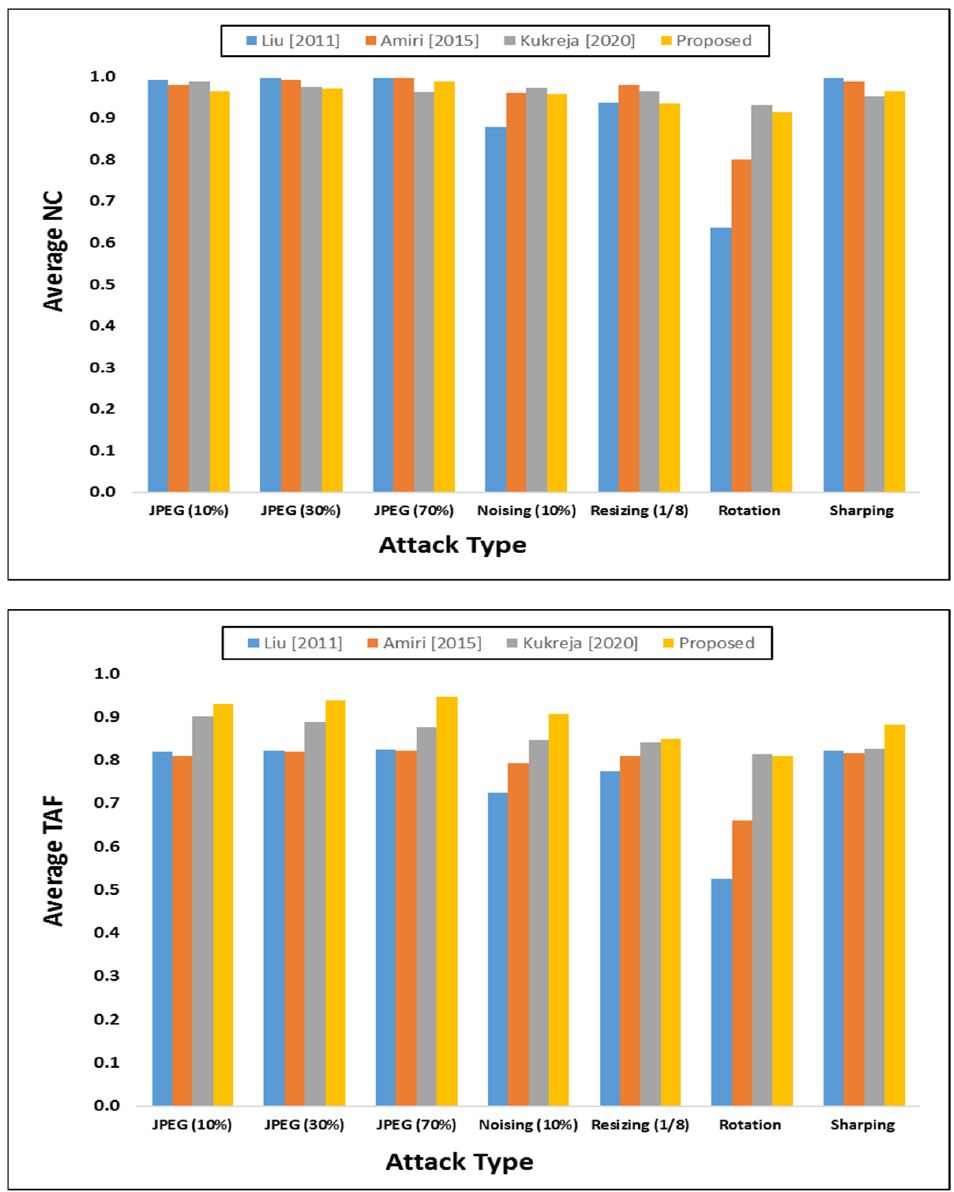
Figure 8. Comparative analysis of the proposed approach with state-of-the-art approaches.